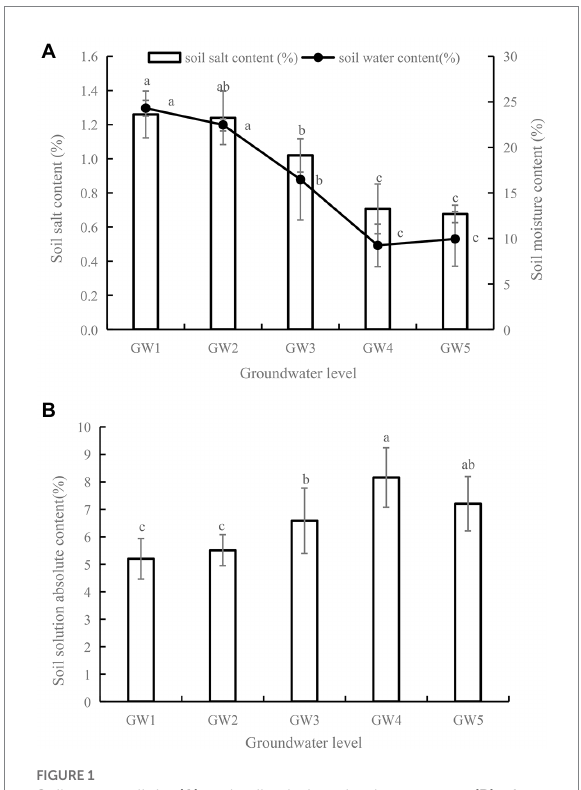
FIGURE 1 Soil water, salinity (A) and soil solution absolute content (B) of Tamarix chinensis shrubland for different groundwater levels. The lower case letters indicate significant and non-significant differences at p < 0.05. The same as